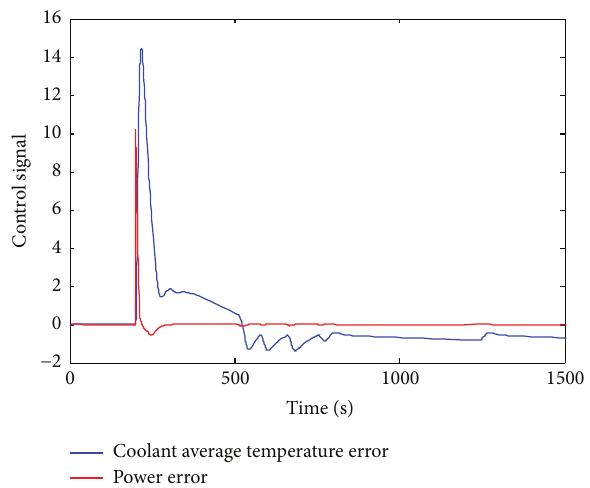
Figure6:Comparisonoftwocontrolsignalsunder10%FPstepload decrease condition.